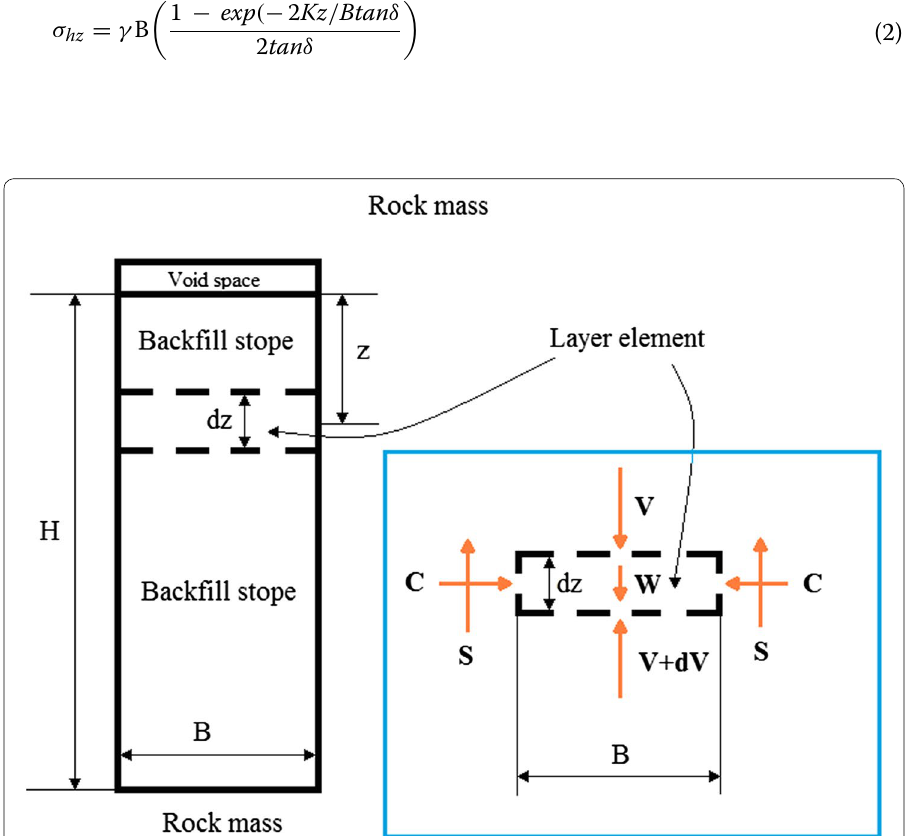
Fig. 1 A vertical backfilled stope and the forces acting on a layer